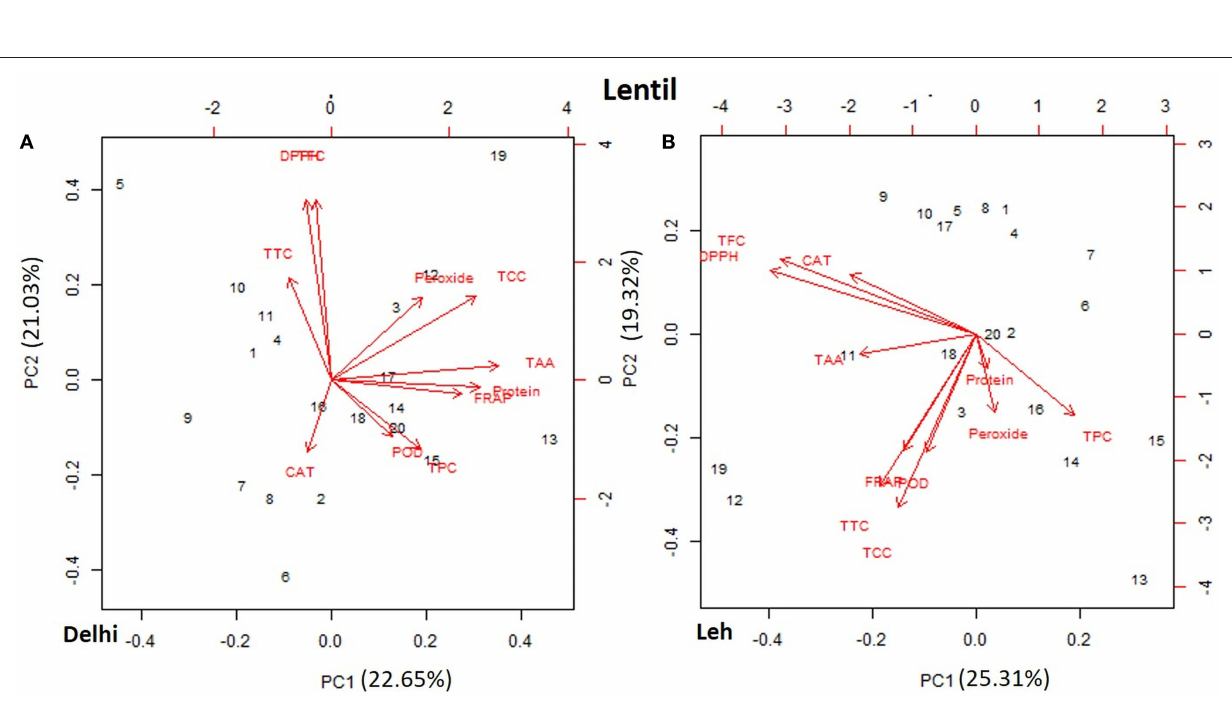
Frontiers in Plant Science | www.frontiersin.org